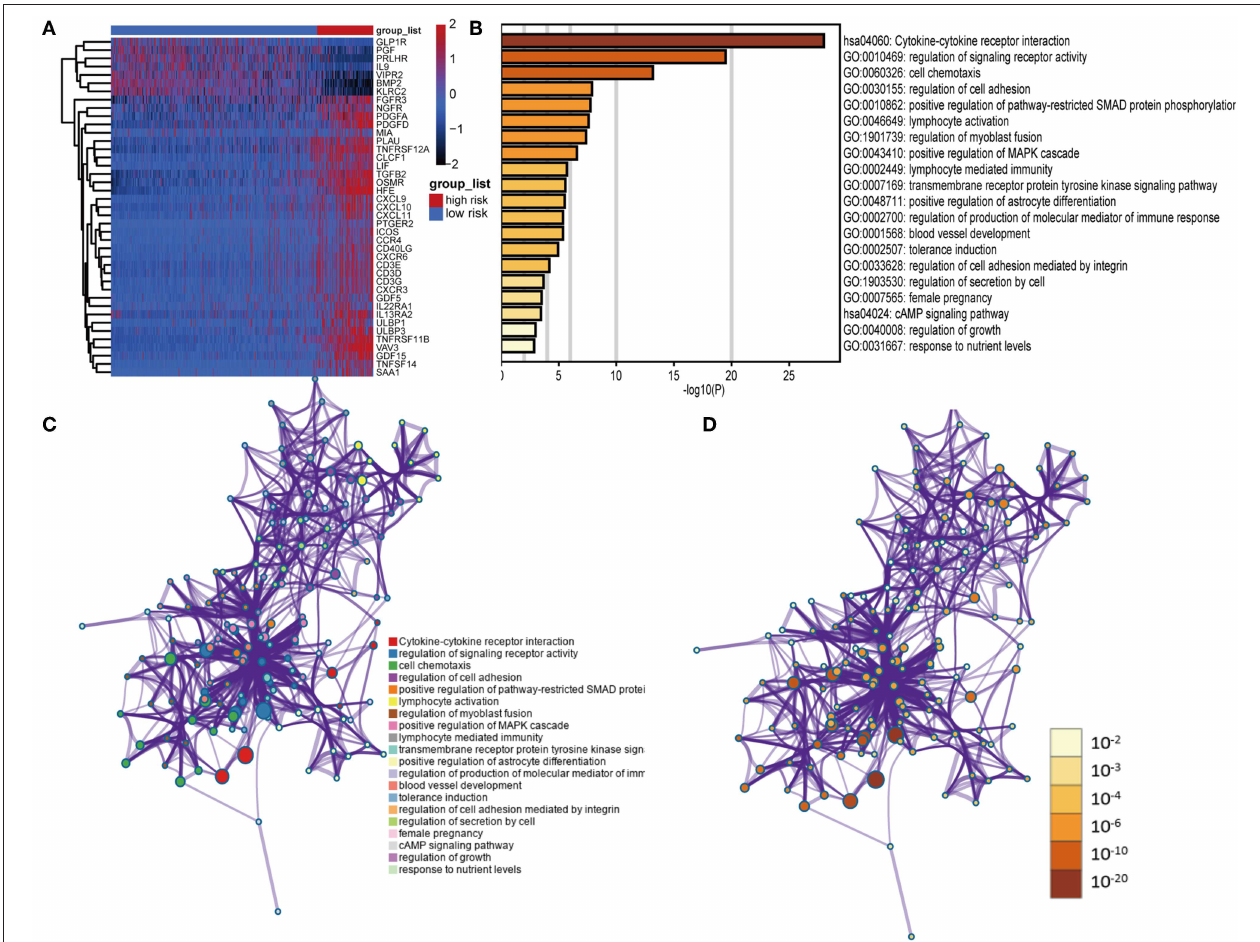
FIGURE 7 | Functional analysis of 41 risk score-associated genes. (A) Heatmap of IDH1-associated immune genes that were differentially expressed between patients with high- and low-risk scores. (B) Heatmap of enriched terms across input gene lists, colored by P -values. Network of enriched terms: (C) colored by cluster ID, where nodes that share the same cluster ID are typically close to each other; (D) colored by P -value, where terms containing more genes tend to have a more significant P -value.